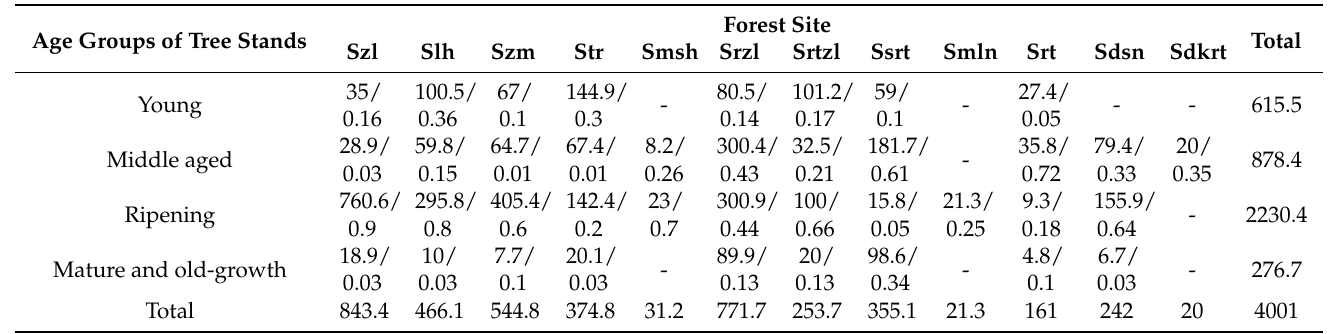
Table 5. Distribution by age groups of forest areas covered by fires depending on forest types (ha)/burning index (%).